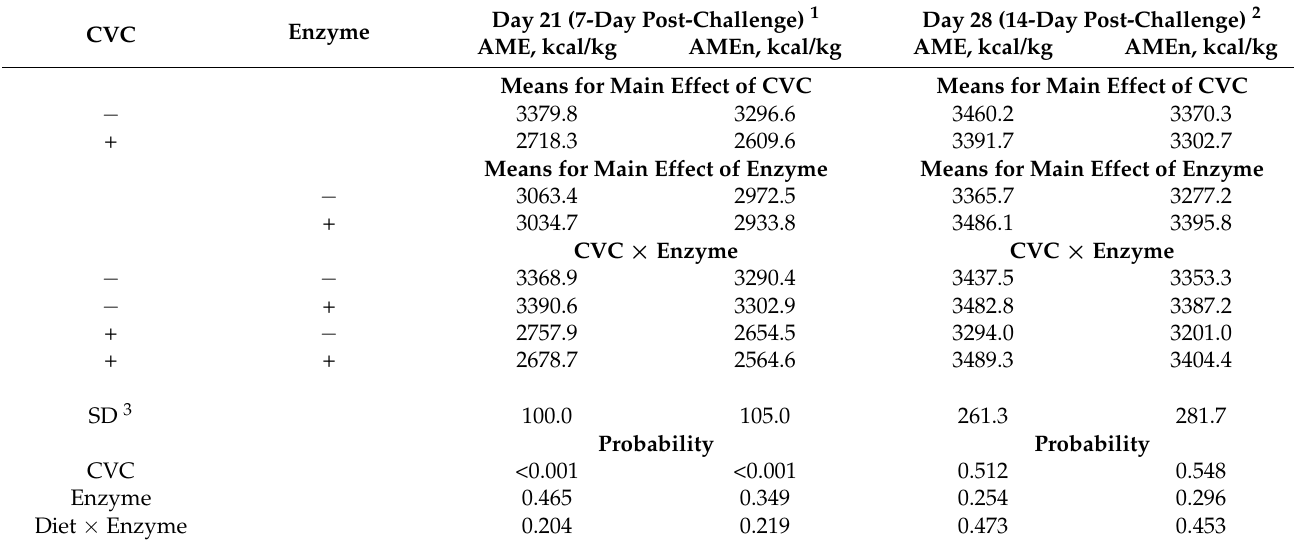
Table 7. Main and simple effects of coccidia vaccine challenge (CVC) and exogenous enzyme supplementation on apparent metabolizable energy (AME) and apparent metabolizable energy corrected for nitrogen (AMEn) of the test ingredient (wheat) 7- and 14-day